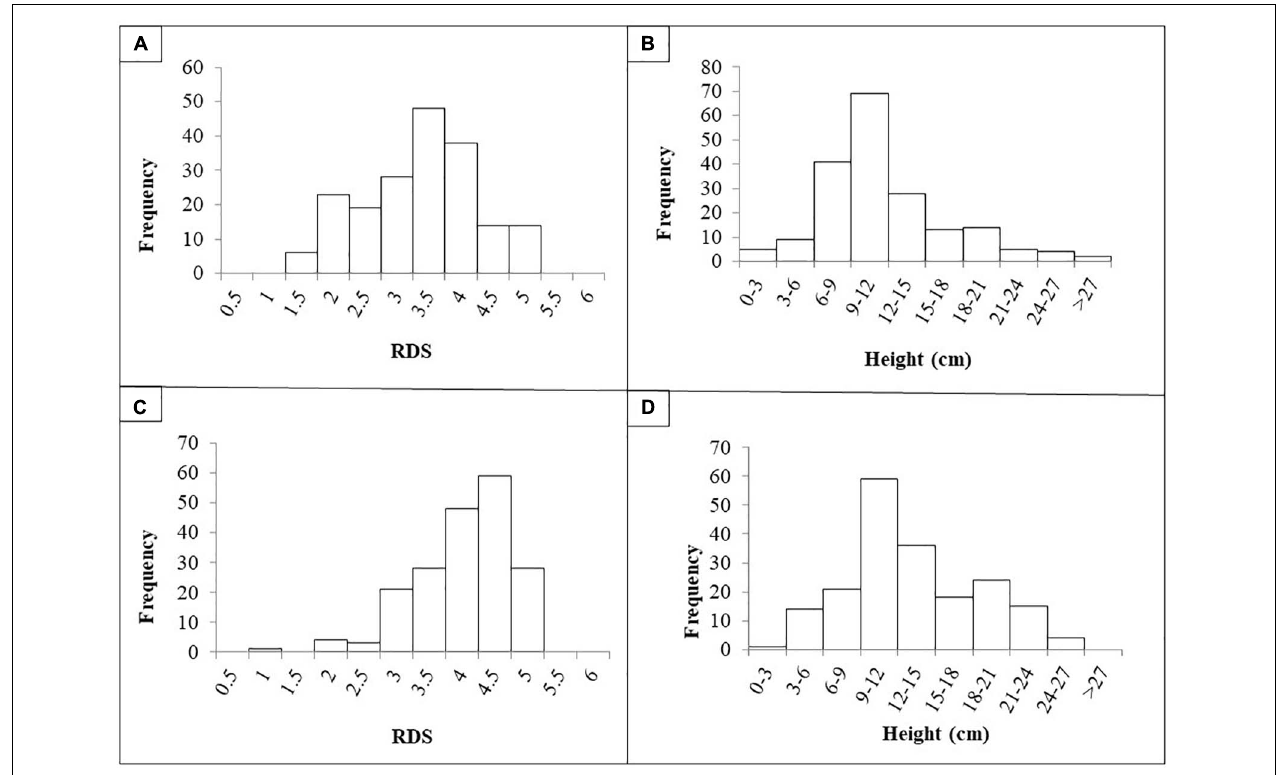
FIGURE 1 | Frequency histograms of root disease severity (RDS) and plant height of recombinant lines (RILs) after challenge with Fusarium solani f. sp. pisi. RILs were derived from crosses “Aragorn” × 00-5001 (A,B) and “Banner” × 00-5007 (C,D) . TABLE 2 | Number of SNPs across eight Pisum sativum genotypes from a total of 769 predicted SNPs.